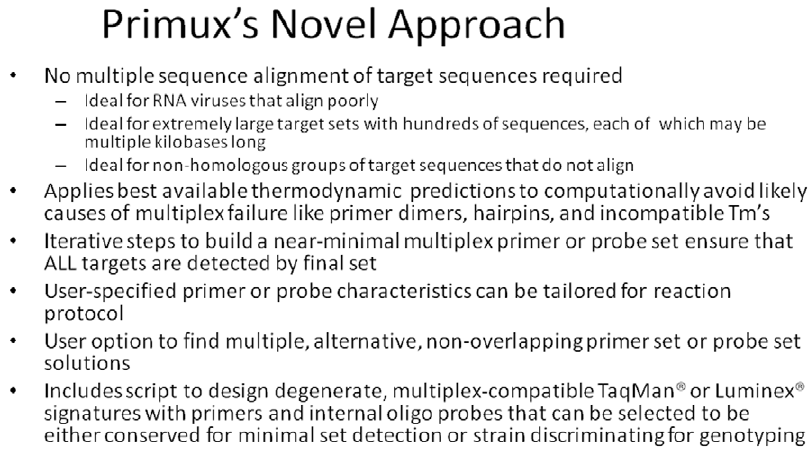
Figure 1. Text box listing important aspects of PriMux.